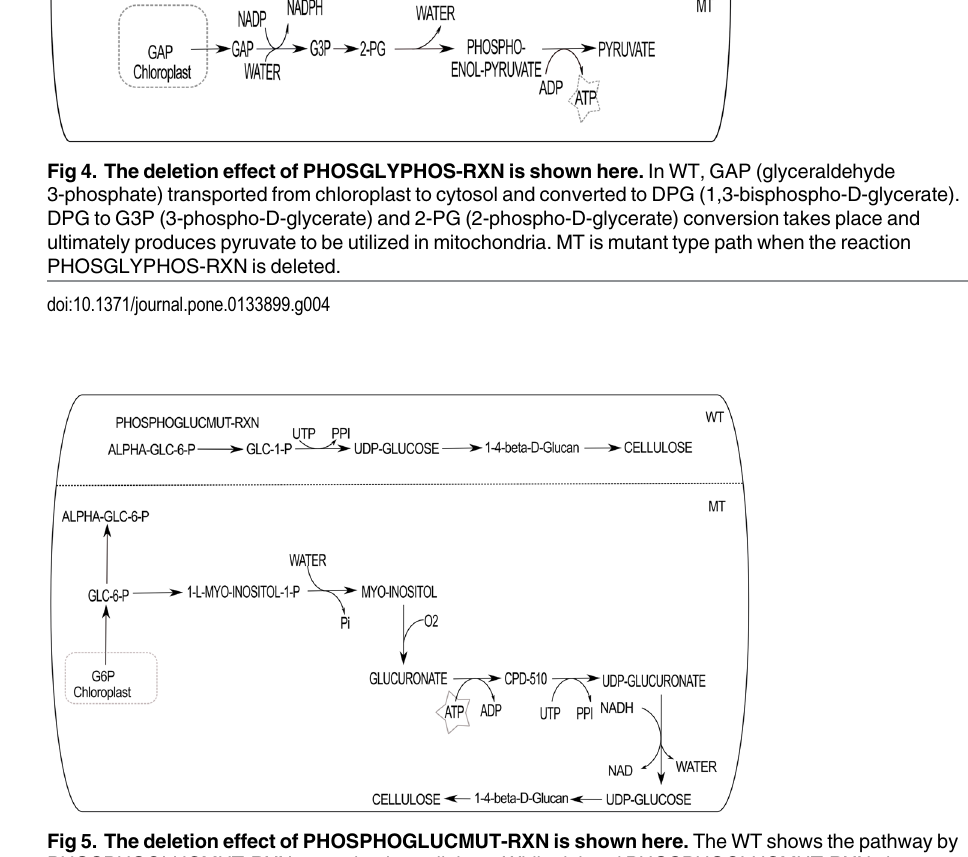
Fig 5. The deletion effect of PHOSPHOGLUCMUT-RXN is shown here. The WT shows the pathway by PHOSPHOGLUCMUT-RXN to synthesize cellulose. While deleted PHOSPHOGLUCMUT-RXN, the alternative possible route via myo-inositol pathway to produce cellulose is shown in